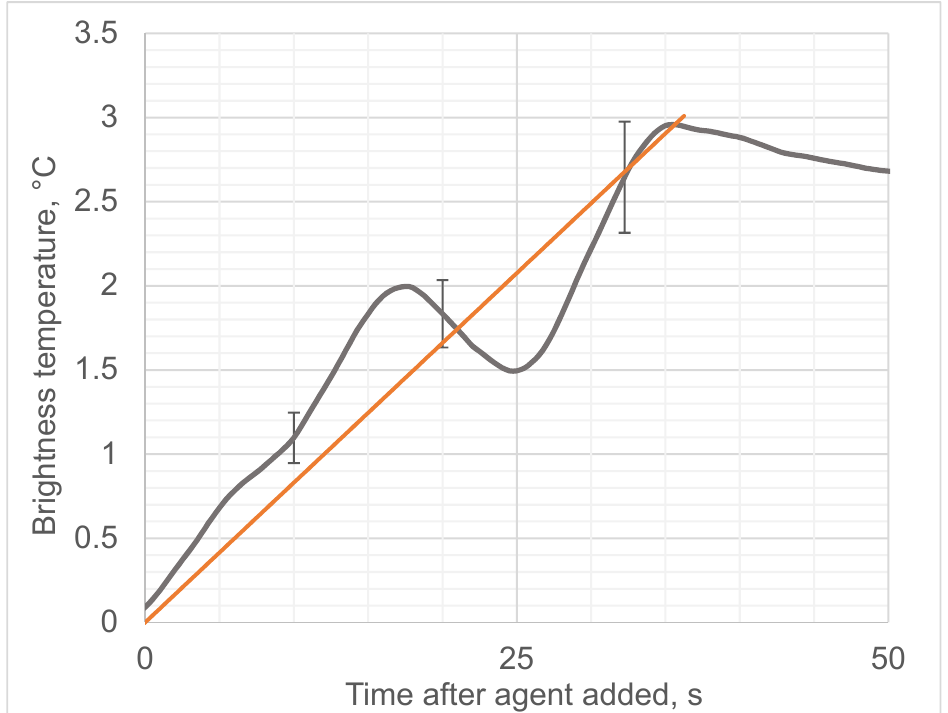
Figure 7. Microwave emissions (brightness temperature) when adding ethanol to tap water during control experiment with no egg white. Black solid line denotes experimental observations. Orange line denotes approximation (slope).